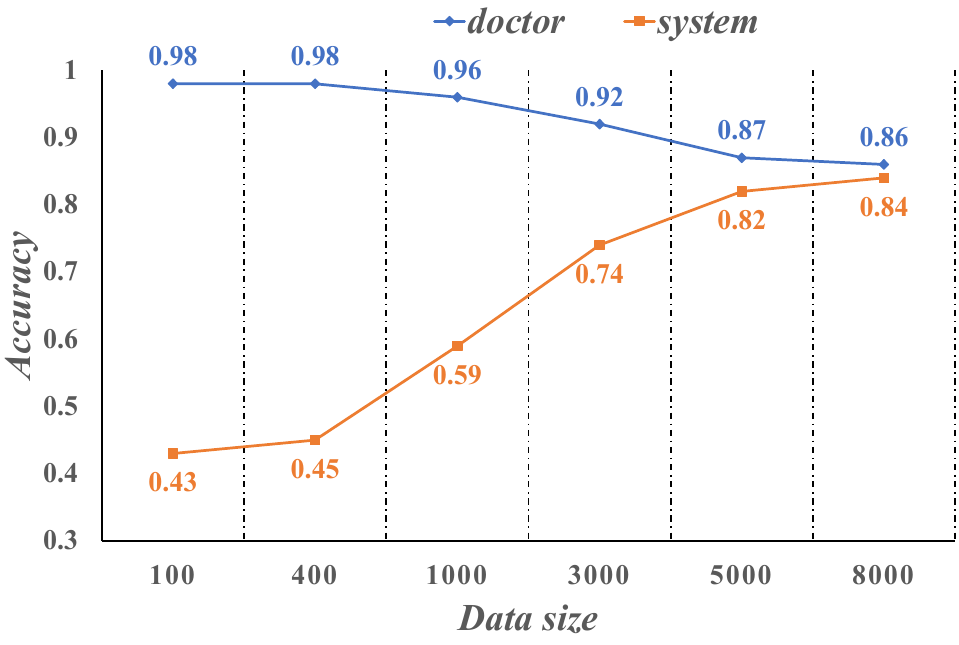
Figure 12. Comparison of doctor and system accuracy.